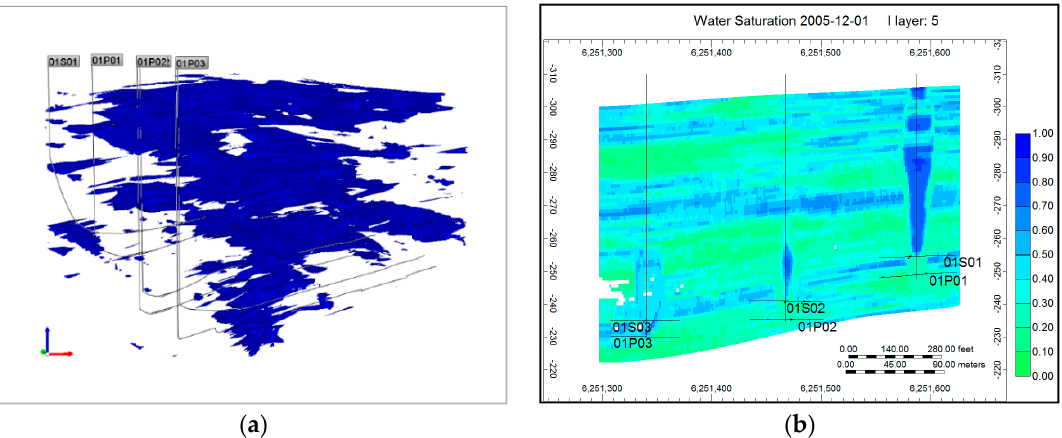
Figure 12. History match of oil and water production rate (( a ) the whole pad; ( b ) well pair 1; ( c ) well pair 2; ( d ) well pair 3).